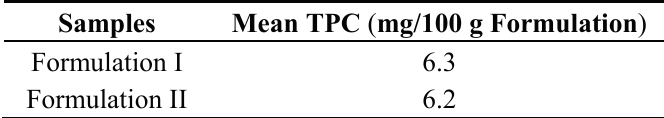
Table 1. Total Polyphenol Content in apitherapy formulations.